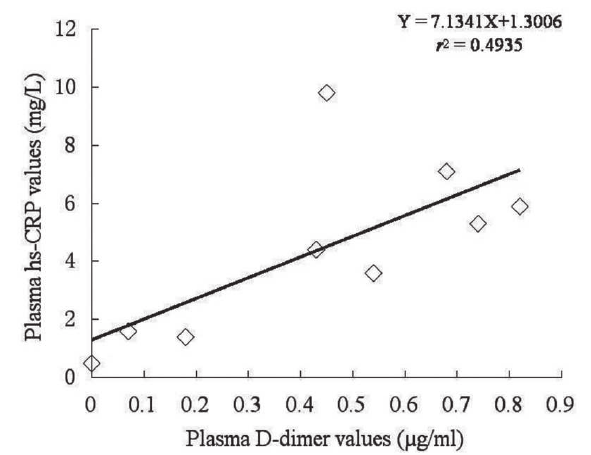
Fig. 7. Linear correlation between plasma D-dimer and plasma hypersensitive C-reactive protein levels of the aortic dissection